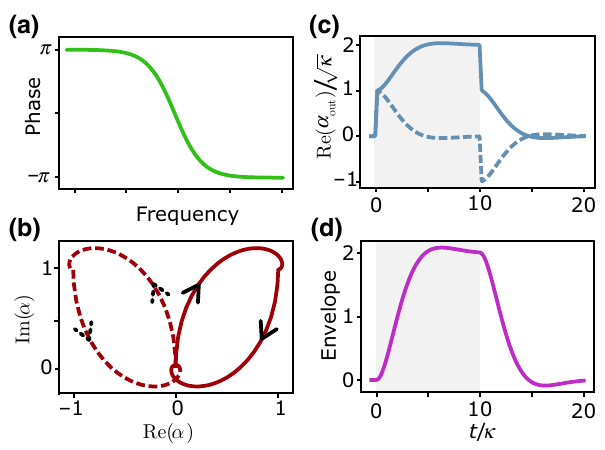
FIG. 12. Readout resonator trajectories for the dispersive readout (a) The phase response of the resonator in standard dispersive readout in the reflection configuration. (b) Average internal state of the readout cavity represented in phase space. The arrows indicate how the state evolves in time. (c) Average reflected signal as a function of time. The light-gray area repre- sents the time during which the input field is on. The trajectory corresponding to the qubit being in | 0 (cid:8) is a blue dashed line and the one corresponding to the qubit being in | 1 (cid:8) is a blue solid line. (d) Average distance between the reflected signal corresponding to the qubit being in | 0 (cid:8) and | 1 (cid:8) . Similarly, the light-gray area represents when the input field is